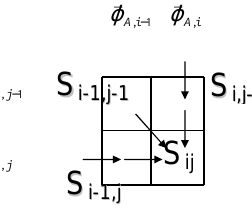
Fig. 8. Derivation directions during the calculation of cell values in the similarity matrix S . Axes x and y of the matrix consists of sequences of energy signatures for two compared proteins A and B